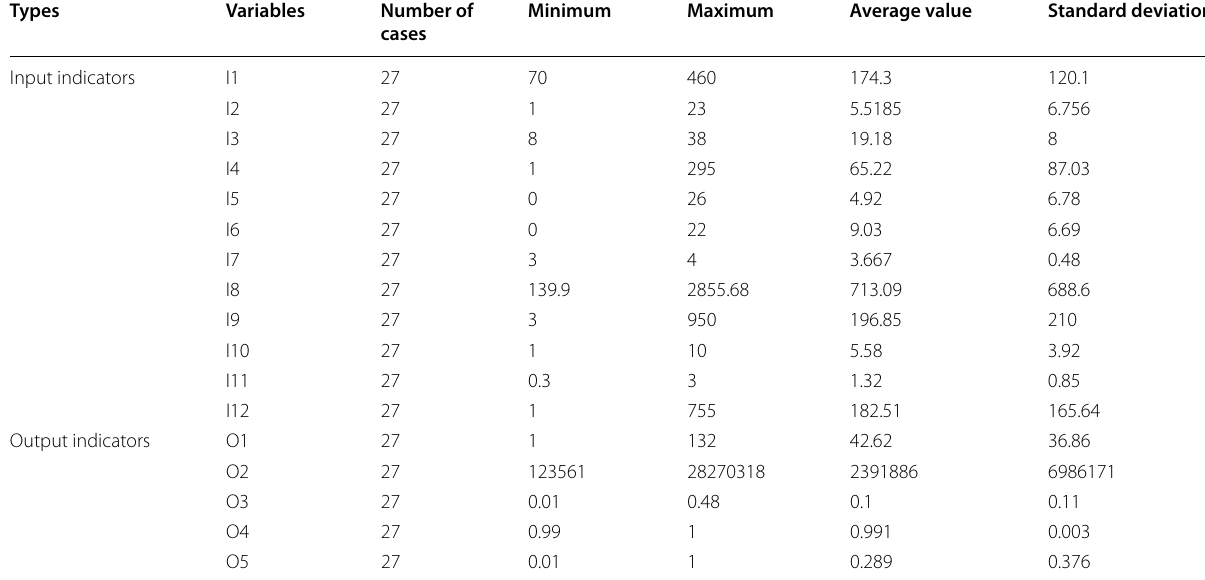
Table 2 Descriptive statistics of input and output variables of government service resources